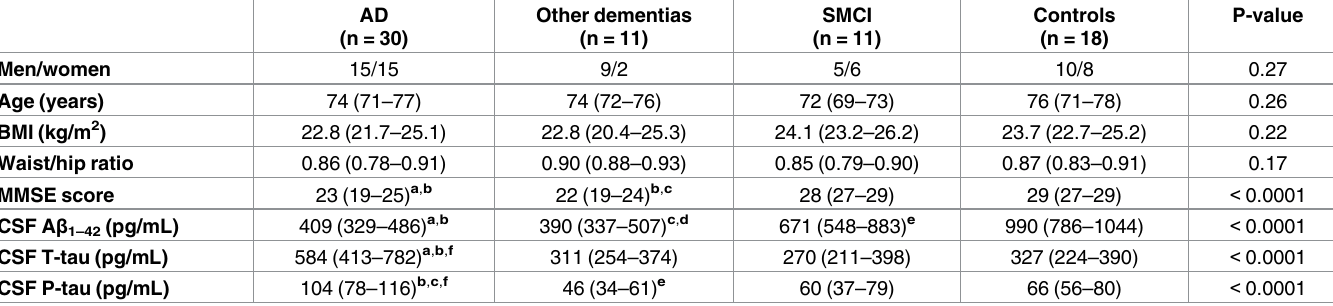
Table 2. Anthropometric measures,MMSE score, and CSF AD biomarkers in 52 patients with cognitive impairment and 18 healthy matched